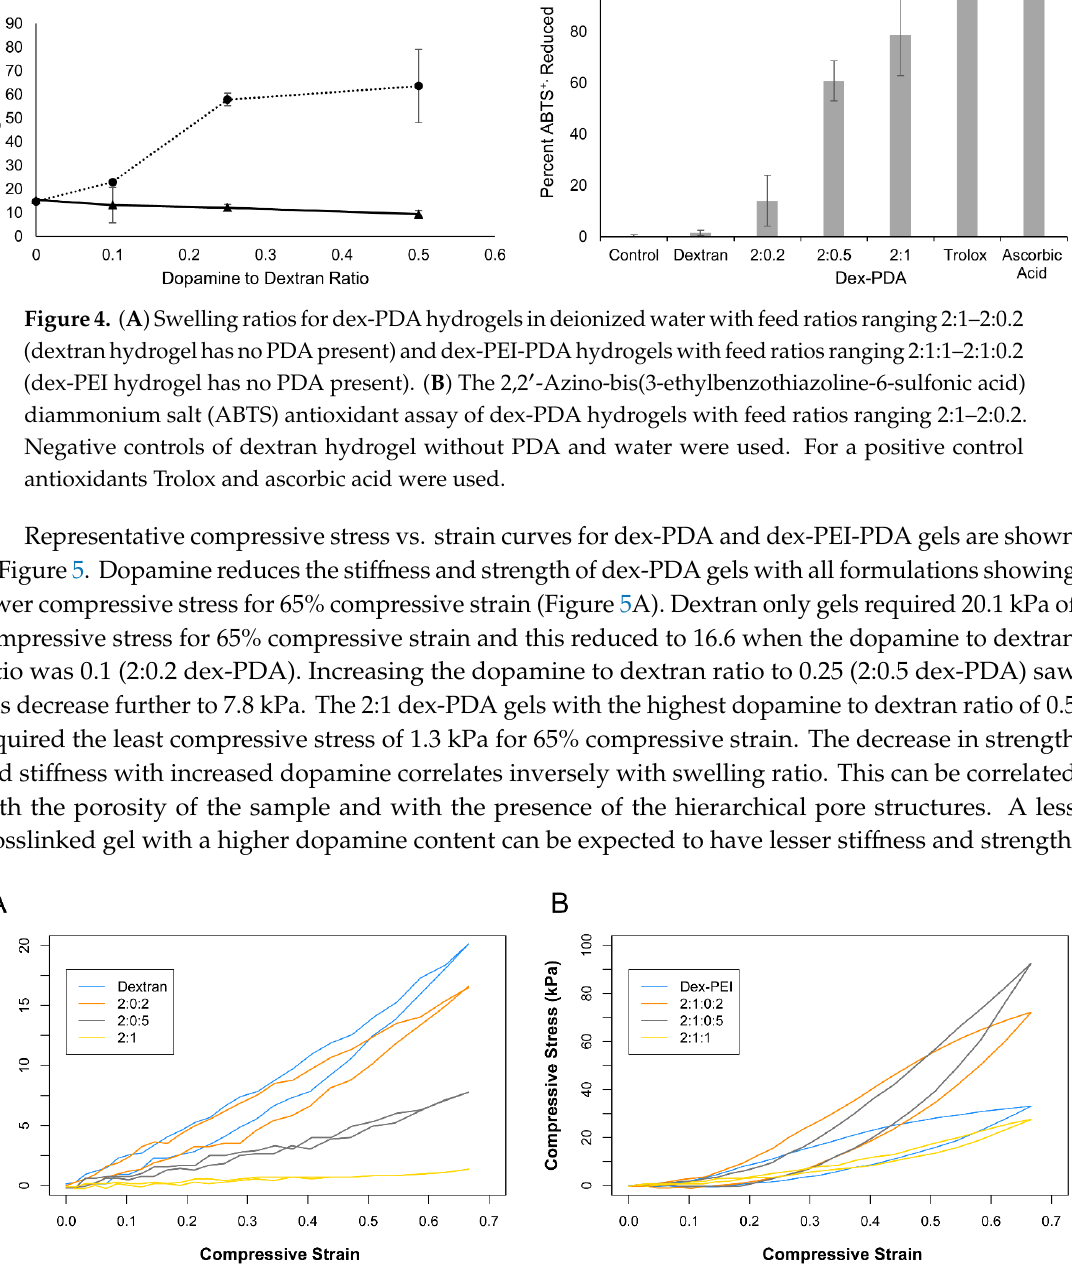
Figure 5. Compressive stress vs. compressive strain curves for ( A ) dex-PDA hydrogels with